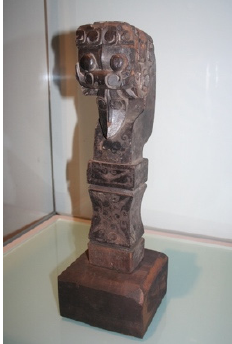
Figure 13. Lacquered wood antlered and tongued sculpture excavated from Tomb 89 at Changsha. Hunan Provincial Museum. Note, the antlers and the original base, which were carved in the Hanxi style, are not pictured. Photo by the author.